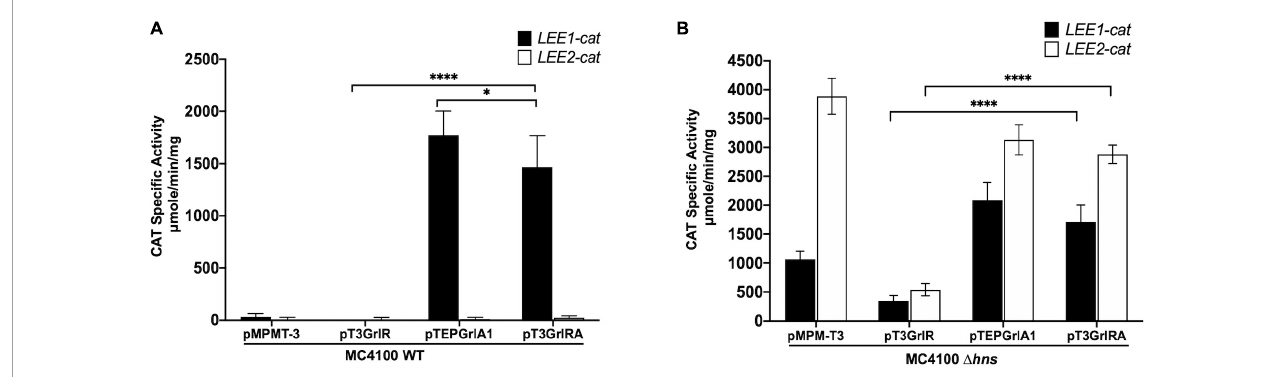
FIGURE9 GrlR represses the expression of LEE1 and LEE2 operons in the absence of H-NS, GrlA and Ler. Expression of LEE1-cat (black bars) and LEE2-cat (white bars) fusions was analyzed in panel (A) WT Escherichia coli MC4100 and (B) MC4100 (cid:49) hns (JPMC1) strains, carrying the empty vector pMPMT-3 or its derivatives pT3GrlR, pTEPGrlA1 and pT3GrlRA grown in 50 ml of Dulbecco’s modified Eagle’s medium (DMEM) with shaking at 37 ◦ C. Specific chloramphenicol acetyltransferase (CAT) activity was determined from samples collected from cultures grown in DMEM at an OD 600 of 1. Values are an average of 3 independent experiments performed in duplicate. Error bars indicate standard deviations. Statistically different values are indicated ( ∗ p -value < 0.1; ∗∗∗∗ p -value < 0.0001).